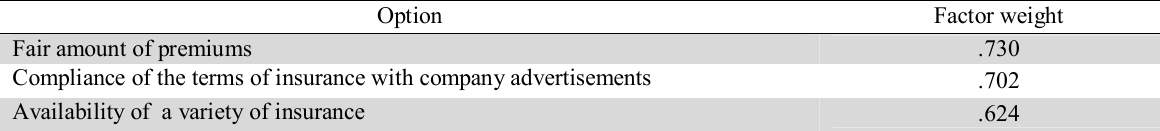
The summary of factors associated with pricing strategy